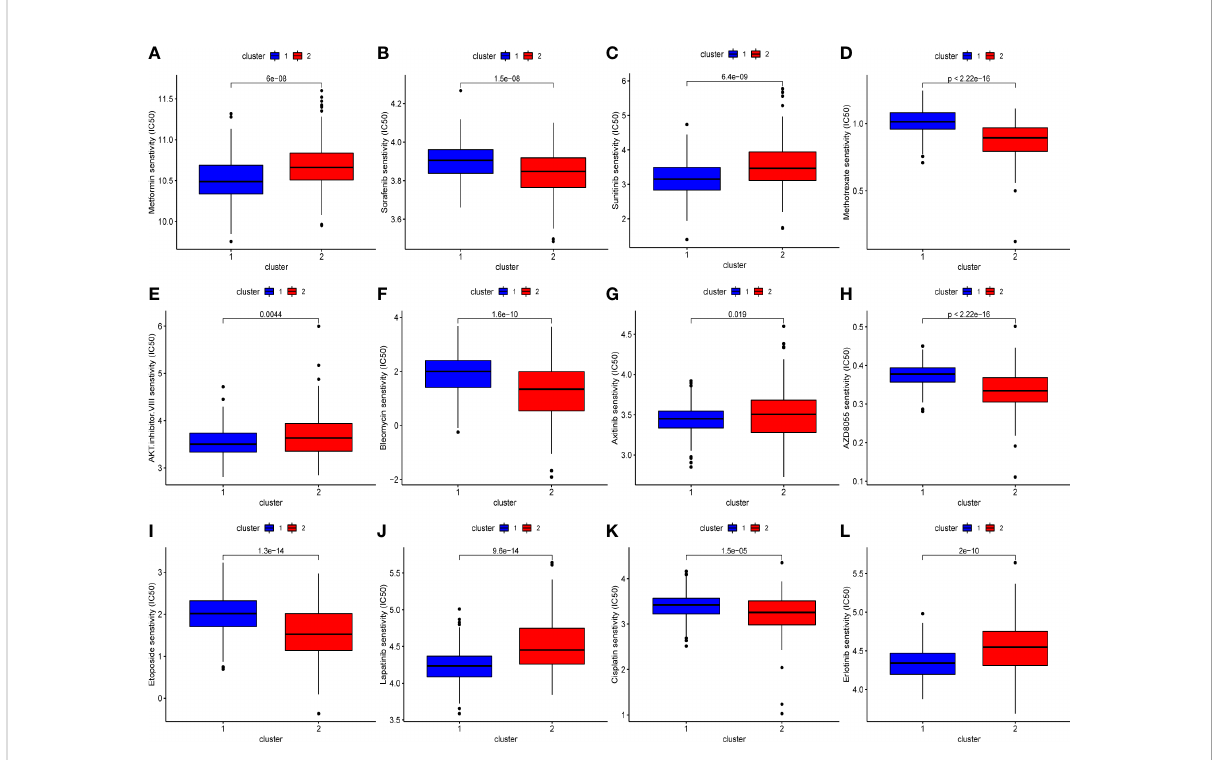
FIGURE 5 The difference of chemo drugs sensitivity between subtypes, including metformin (A) , sorafenib (B) , sunitinib (C) , methotrexate (D) , AKT.inhibitor.VIII (E) , bleomycin (F) , axitinib (G) , AZD8055 (H) , etoposide (I) , lapatinib (J) , cisplatin (K) , erlotinib (L) .